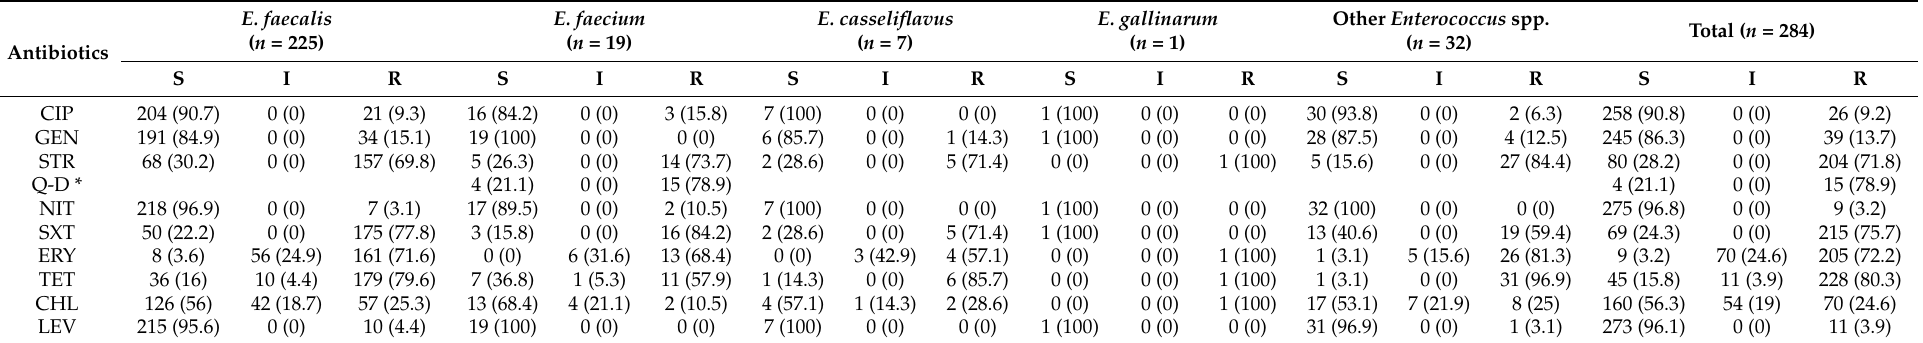
Table 1. Susceptibility profiles of Enterococcus species to the antibiotics